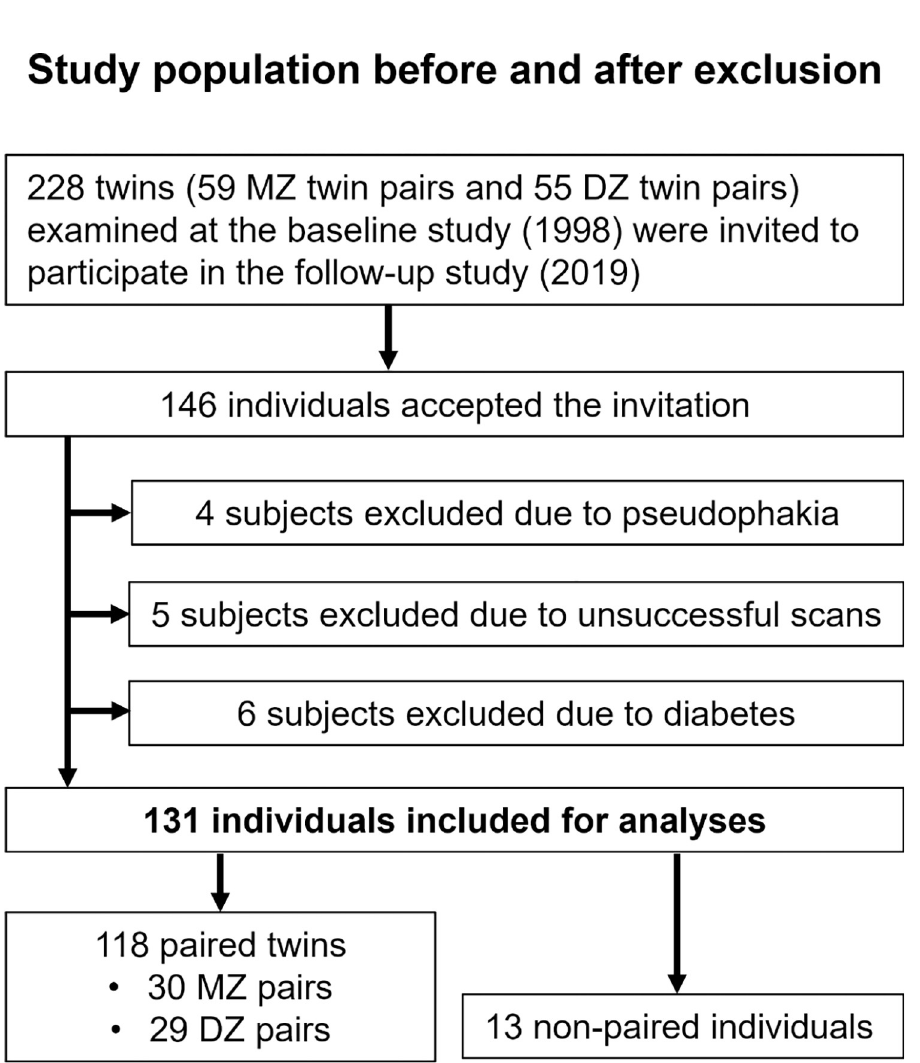
Fig 1. Study population before and after